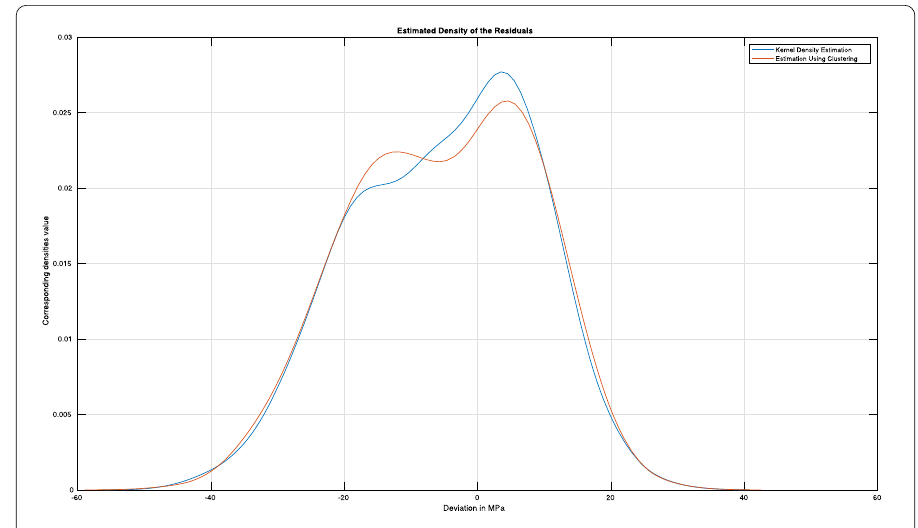
Figure 13 The density of the distribution of the residuals estimated using a Gaussian kernel and measurements is given in blue, the mixture of the densities estimated using the link-function in orange. The difference is minimal due to bias-effects which vanishes asymptotically